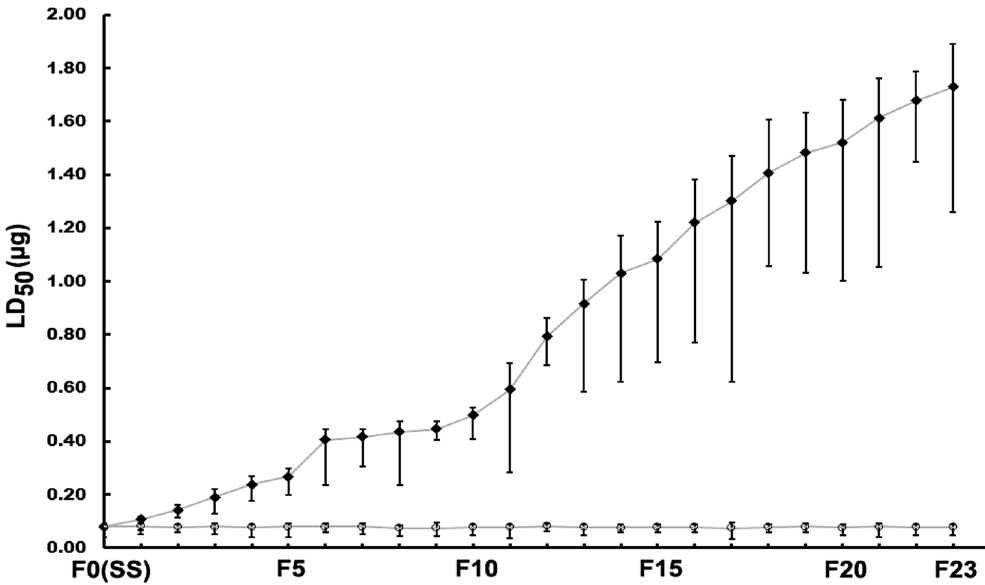
Figure 1. The LD 50 development curve of German cockroach selected by CPF. O: control strain, ◆: CPF resistant strain. LD 50 : 50% lethal dose. Date were expressed as LD 50 and the 95% confidence limit. Data were pooled from three independent experiments and subjected to regression/probit analysis using SPSS 13.0 to estimate the LD 50 and 95% confidence